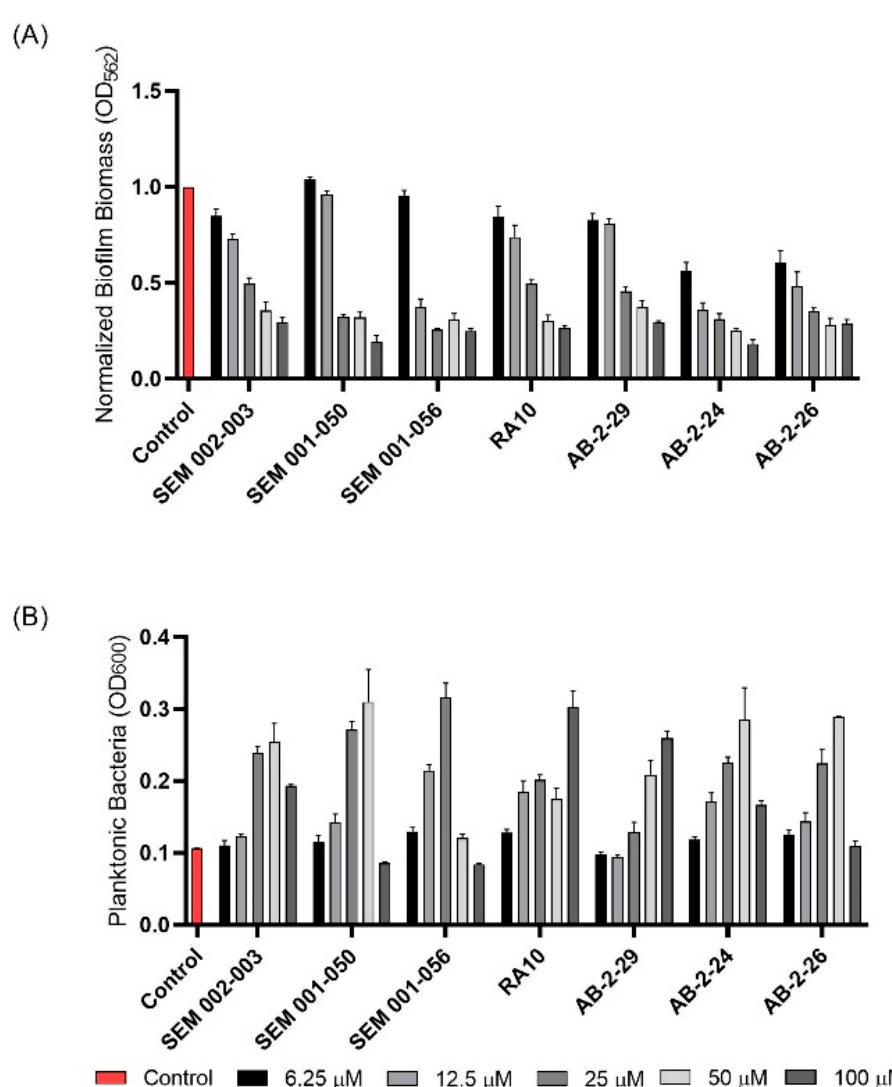
Figure 1. Effect of 2-aminoimidazoles on M. abscessus biofilm formation . ( A ) Biofilm formation of 2-AI-treated Mmas CIP 108297 cultures after 5 days of growth in SCFM medium in poly-D-lysine- coated microplates as determined by crystal violet staining. The compounds were added to the culture medium at the indicated concentrations on the first day and maintained throughout the duration of the experiment. The control corresponds to DMSO diluent (0.2% final concentration) without any added 2-AI compound. ( B ) In parallel, the turbidity of planktonic bacteria released in the medium was assessed spectrophotometrically at 600 nm. Inhibition of biofilm formation correlates with an increase in planktonically growing bacteria in the wells. Decreases in both biofilm and planktonic growth are indicative of the inhibitors having reached their MIC values. The results presented are the means ( ± SD) of quadruplicate wells and are representative of at least two independent experi- ments.